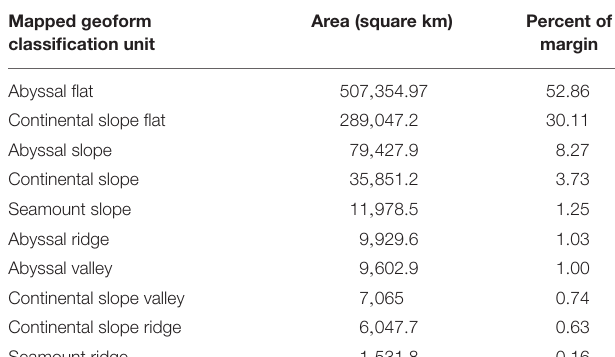
TABLE 2 | Geoform classes of the Atlantic Margin study region by area and percentage.